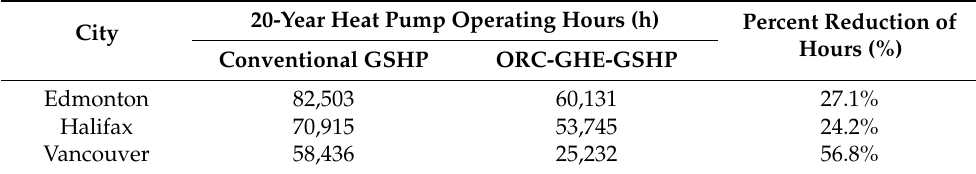
Table 7. Heat pump operating hours during the 20-year period for both systems in each city.